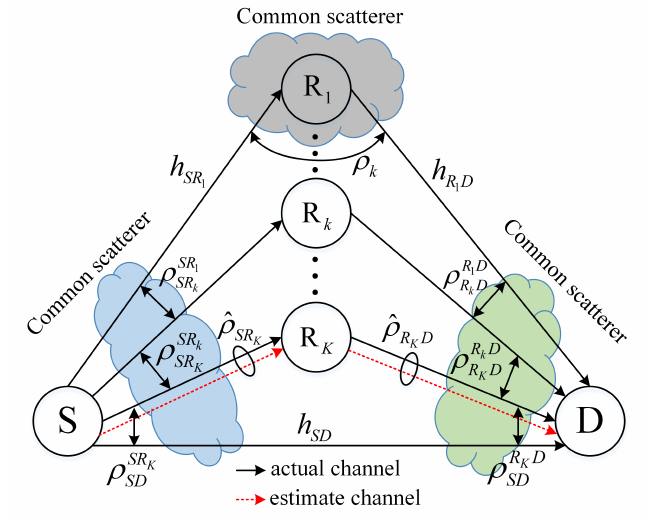
Figure 1. A multi-relay system in a general correlated environment. Table 1. A summary of channel correlation